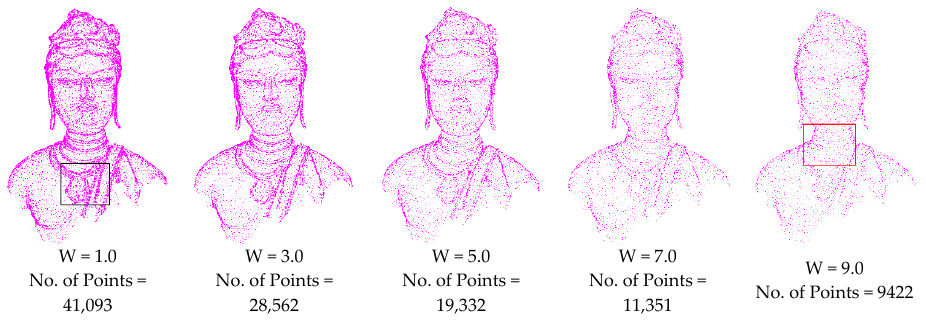
Figure 13. Results of level δ = 3.0 with different weight coefficients ( λ = 4.0).